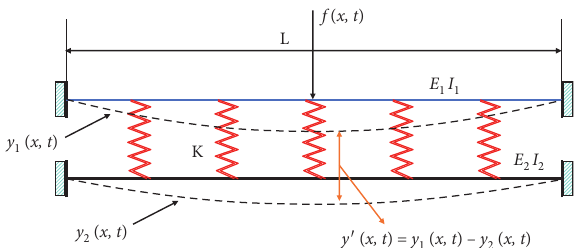
Figure 8: Equivalent model of the composite beam